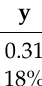
Table 3. Static accuracy test summary results.